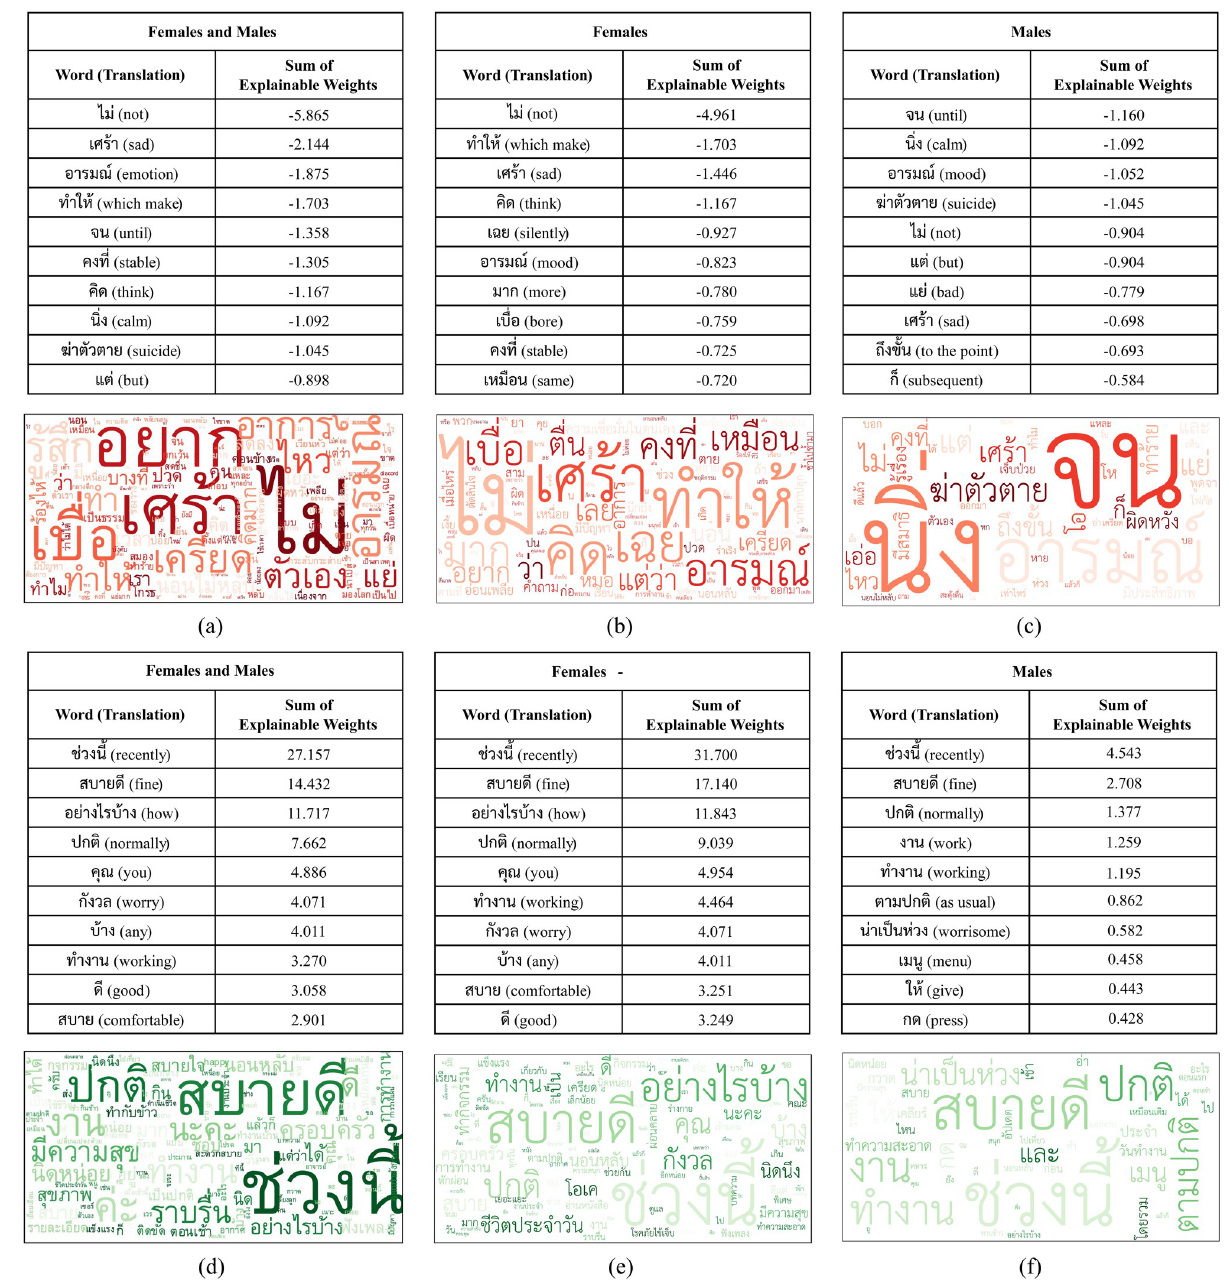
Fig 3. Word cloud of the responses to the question “How are you these days?” from six different groups: a) depressed females and males, b) depressed females, c) depressed males, d) normal control females and male, e) normal control females, and f) normal control males.